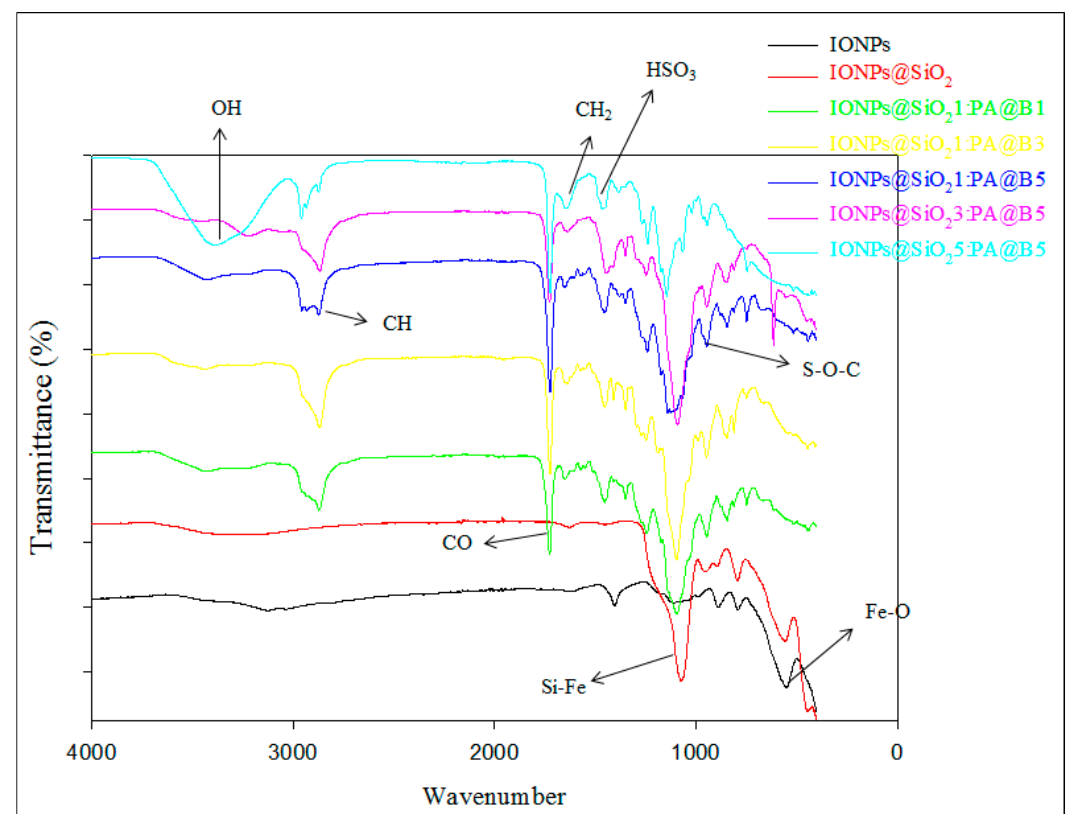
Figure 3. FTIR spectra of pure IONPs, IONPs@SiO 2 , and the fabricated MCM-PA@B with different ratios of IONPs@SiO 2 and PA@B.